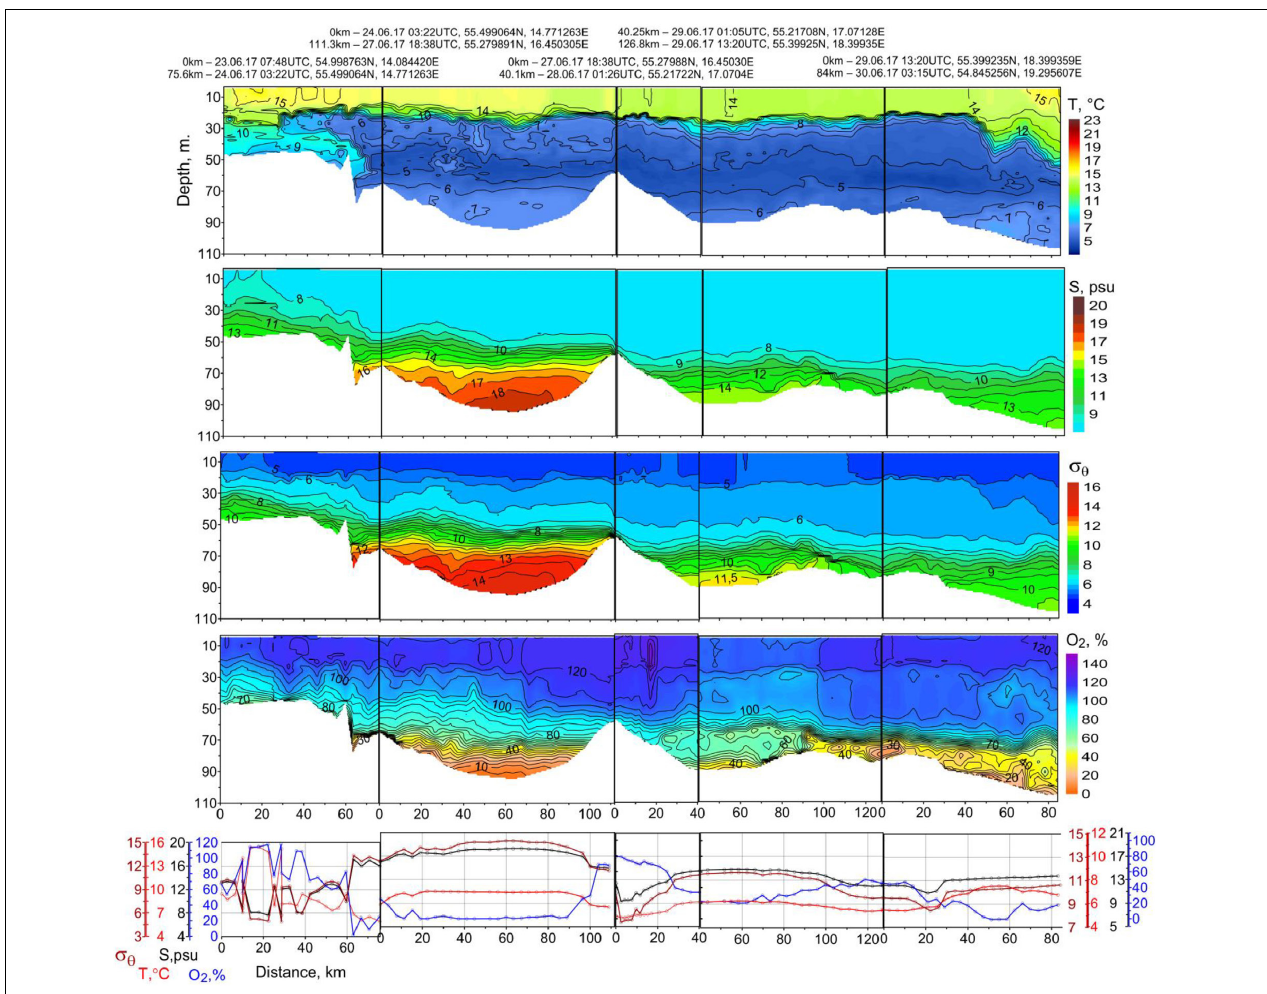
FIGURE 7 | Distributions of temperature T ( ◦ C), salinity S (psu), density σ θ , and oxygen saturation O 2 (%) in the southern Baltic for the 2nd survey (June–July 2017); bottom panels demonstrate graphs of the same parameters in the bottom